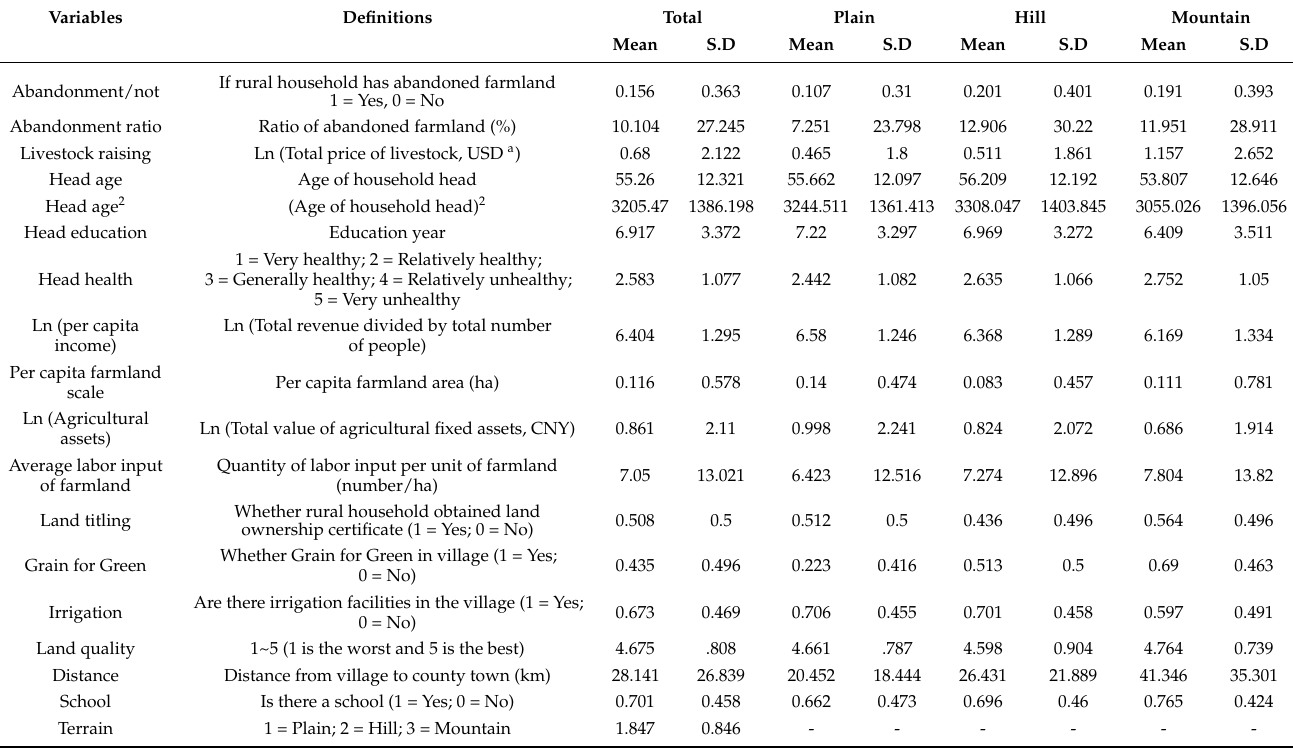
Table 1. Definition and summarized statistics for variables. Note: USD a : US